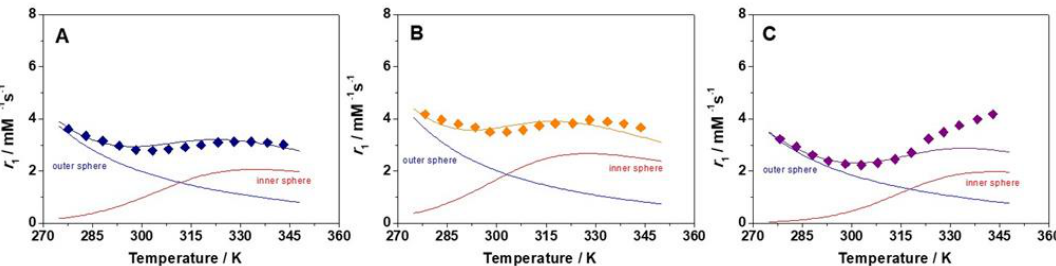
Figure 2. Temperature dependence of the 1 H relaxivity at 20 MHz (pH 7) of GdL1 (( A ) 2.8 mM), GdL2 (( B ) 2.7 mM), and GdL3 (( C ) 4.4 mM). The solid lines represent the fits of the data with the parameters reported in Table 1. The dotted lines identify the inner- and outer-sphere contributions.